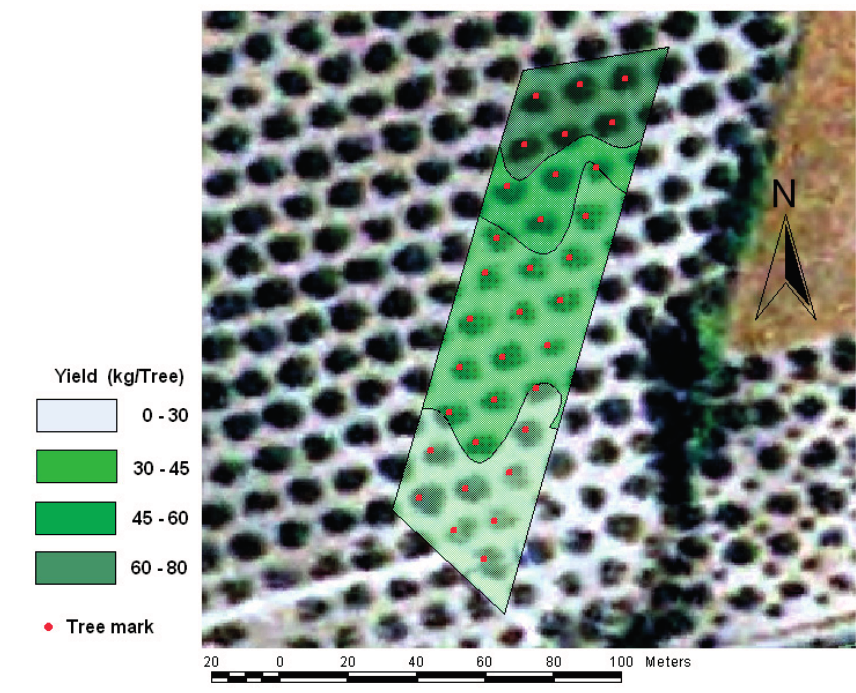
Figure 7. Olive fruit yield map estimate in a conventional orchard